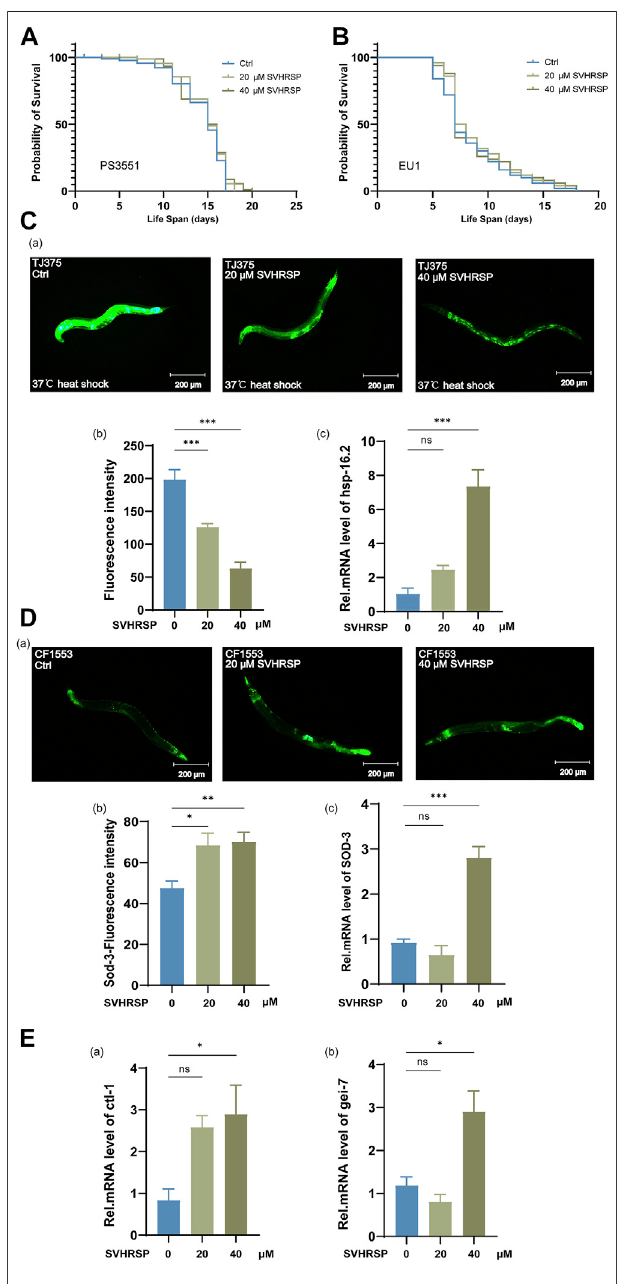
FIGURE 4 | Scorpion venom heat – resistant synthesized peptide (SVHRSP) regulates downstream gene expression of the IIS pathway. (A) effects of 20- and 40- μ M SVHRSP untreated treatments on the lifespan of PS3551 nematodes. (B) -effects of 20- and 40- μ M SVHRSP untreated treatments on the lifespan of EU1 nematodes. (C) (a) fl uorescence images of TJ375nematodestreatedwith20-and40- μ MSVHRSP,anduntreatedunder heat stress. (b) the GFP strength from the TJ375 strain was treated with 20- and 40- μ M SVHRSP. (c) Hsp-16.2 mRNA levels in worms treated with 20- and 40- μ M SVHRSP and controls. (D) (a) fl uorescence images of CF1553 nematodes treated with 20- and 40- μ M SVHRSP, and untreated. (b) the GFP intensity of CF1553(muIs84) strain after 20- and 40- μ M SVHRSP treatment was determined. (c) Sod-3mRNA levels in worms treated with 20- and 40- μ M SVHRSP and controls. (E) (a) Ctl-1 mRNA levels in worms treated ( Continued )